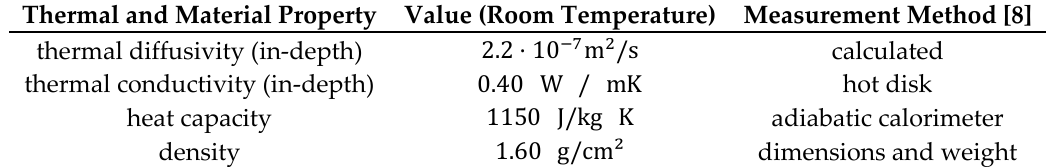
Table 1. Thermal and material properties to the material, determined within the VITCEA-project. The methods are described in Ref. [8]